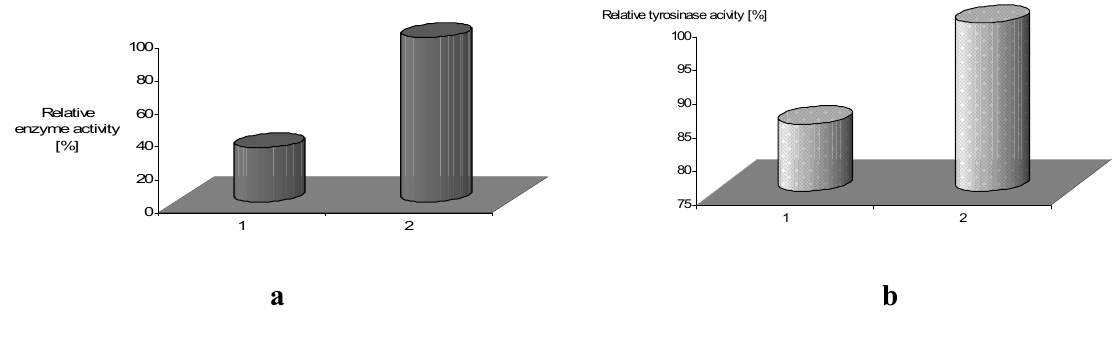
Figure 13. Activity of laccase – a and tyrosinase- b immobilized in LB film, 1-without 4 as mediator, 2-with 4 , substrate-ABTS (0.228